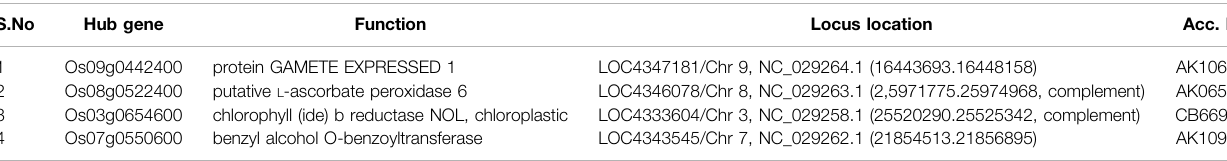
TABLE 5 | Identi fi ed hub genes with respect to their level of connectivity in the yellow module. S.No